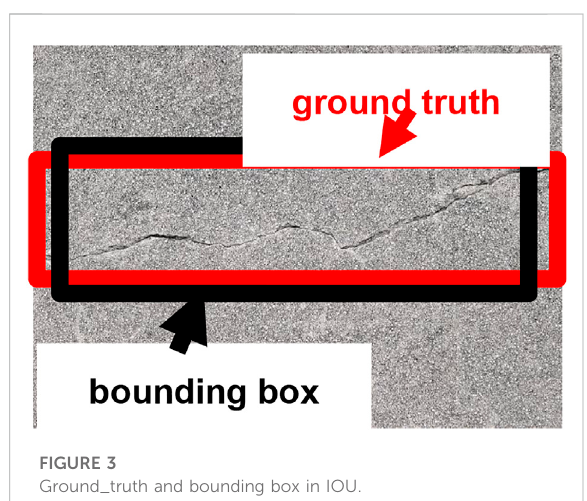
Ground_truth and bounding box in